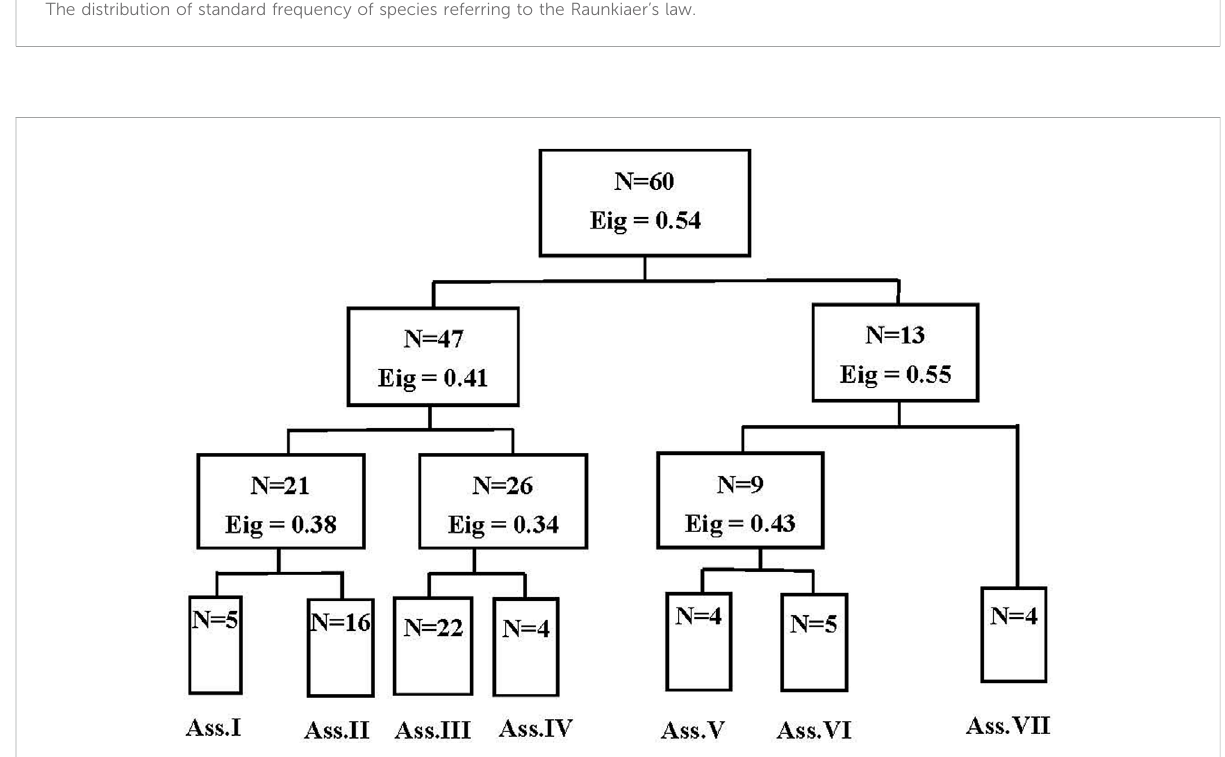
FIGURE 3 Dendrogram of TWINSPAN (two-way indicator species analysis) classi fi cation for plant species. (Note: Eig =